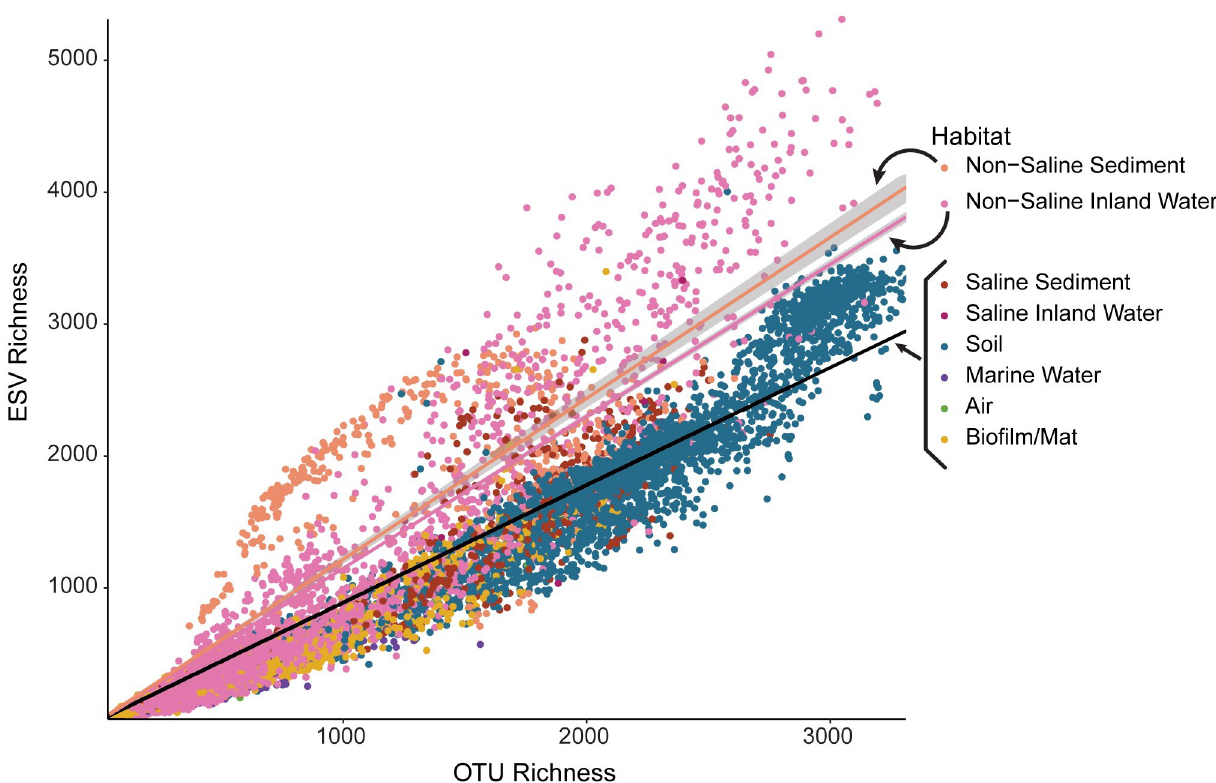
Fig 4. Comparison of OTU and ESV richness. On a sample-by-sample basis, OTU richness and ESV richness are highly correlated (r 2 = 0.933, P < 0.0001). On average, for any given sample, ESV richness is equal to 95.26% of OTU richness. However, not all habitats showed the exact same relationship between OTU and ESV richness. Non-saline sediment and inland water samples have significantly higher ESV richness given their relative OTU richness. All samples except for non-saline sediment and inland water have a regression line with a slope of 0.891 (P < 0.0001, r 2 = 0.971), shown as the black regression line on the graph. Non-saline sediment samples have a regression line with a slope of 1.220 (P < 0.0001, r 2 = 0.895), shown as light orange on the graph. Non-saline inland water samples have a regression line with a slope of 1.152 (P < 0.0001, r 2 = 0.902), shown as light pink on the